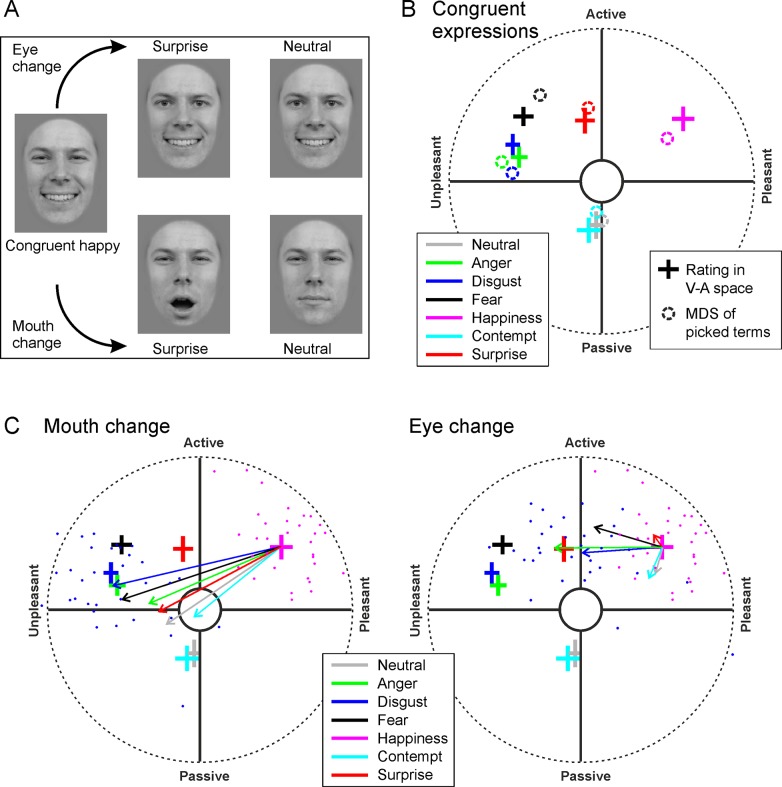
Data from the two measurement methods are in agreement.A) Examples of the congruent and incongruent stimuli used in the experiment. B) Perceptions of congruent emotional expressions as reflected in the direct V-A-ratings (crosses, where the width indicates the 95% CI over participants) and MDS analysis of terms selected from a list (circles). For presentation purposes, the MDS analysis result was transformed, whilst keeping the structure of the data intact (isotropically scaled and rotated). Our simulations (10 000 randomizations) showed that the probability that such a strong correspondence (as indicated by sum of squares of location differences) between the structures of the rating data and the MDS analysis would occur by chance is very low (p<0.001). C) Examples of changes in the perception when either the mouth (left) or eye (right) region was changed from the congruent expression. The point of the arrow indicates the point to which perception on average shifted in the V-A space. For example, when mouth was changed from happy to disgusted (left), whilst the eyes remained happy, perception shifted quite completely to a point corresponding to the perception of congruent disgust (long blue arrow originating from the magenta cross). Each small dot represents the average of one participant’s ratings in corresponding conditions (magenta: congruent happy, blue: mouth (left) or eyes (right) changed to disgusted).